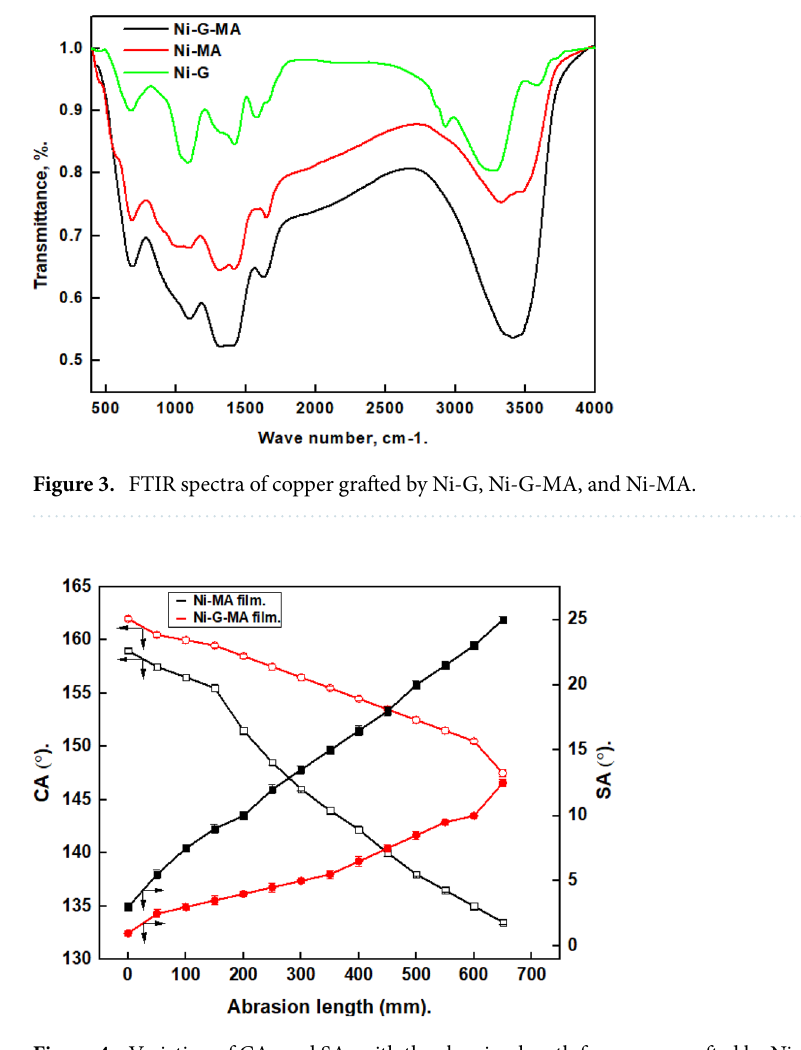
Figure 4. Variation of CAs and SAs with the abrasion length for copper grafted by Ni-MA film and Ni-G-MA